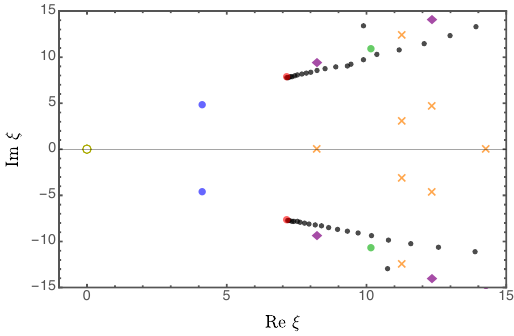
Figure 2 . Poles of the Borel-Pad(cid:19)e approximant BP 90 [ (cid:14) 1 (cid:8) 0 ]. Comparing the (cid:12)gure above to the top plot of (cid:12)gure 1 we can see that the singularity structure of the leading sector can be consistently removed from the coe(cid:14)cients of (cid:8) 0 , and the information of the higher sectors can be recovered. The slight asymmetry in the (cid:12)gure above is due to the particular choice of lateral resummation where we have integrated along the real line from